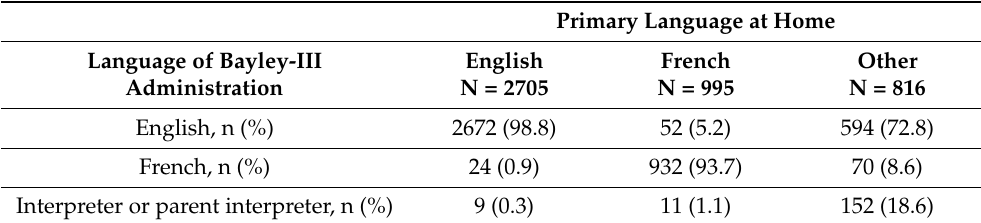
Table 3. Primary language at home and language used for Bayley-III administration.